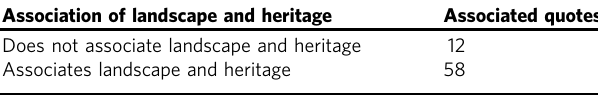
Table 18 Relationship of landscape and heritage.